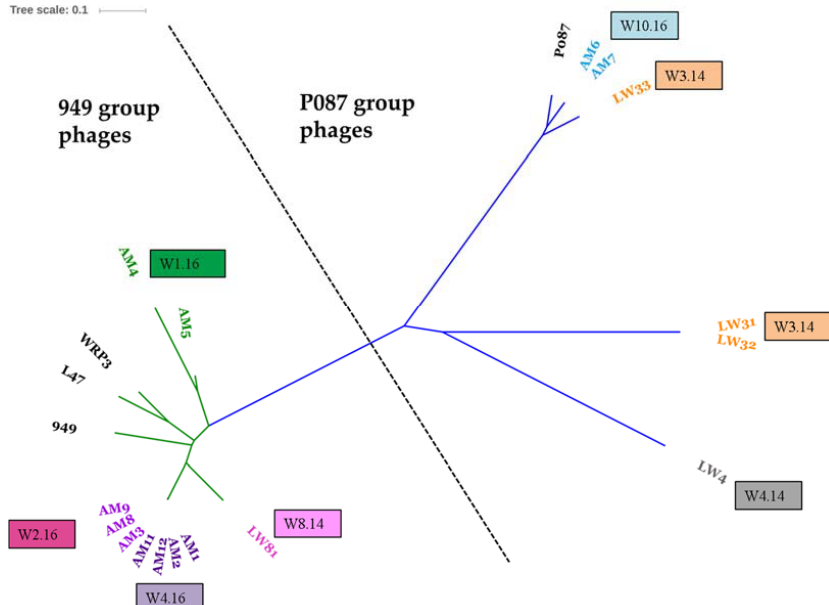
Figure 1. Unrooted phylogenetic tree of the complete nucleotide sequences of the 949 (green branches) and P087 (blue branches) isolates from this study and previously sequenced members 949, L47, WRP3, and P087. Whole phage nucleotide alignment was performed via ClustalW V2.1. Subsequently, the phylogenetic tree was generated using the neighbor ‐ joining method and bootstrapped (×1000) replicates.